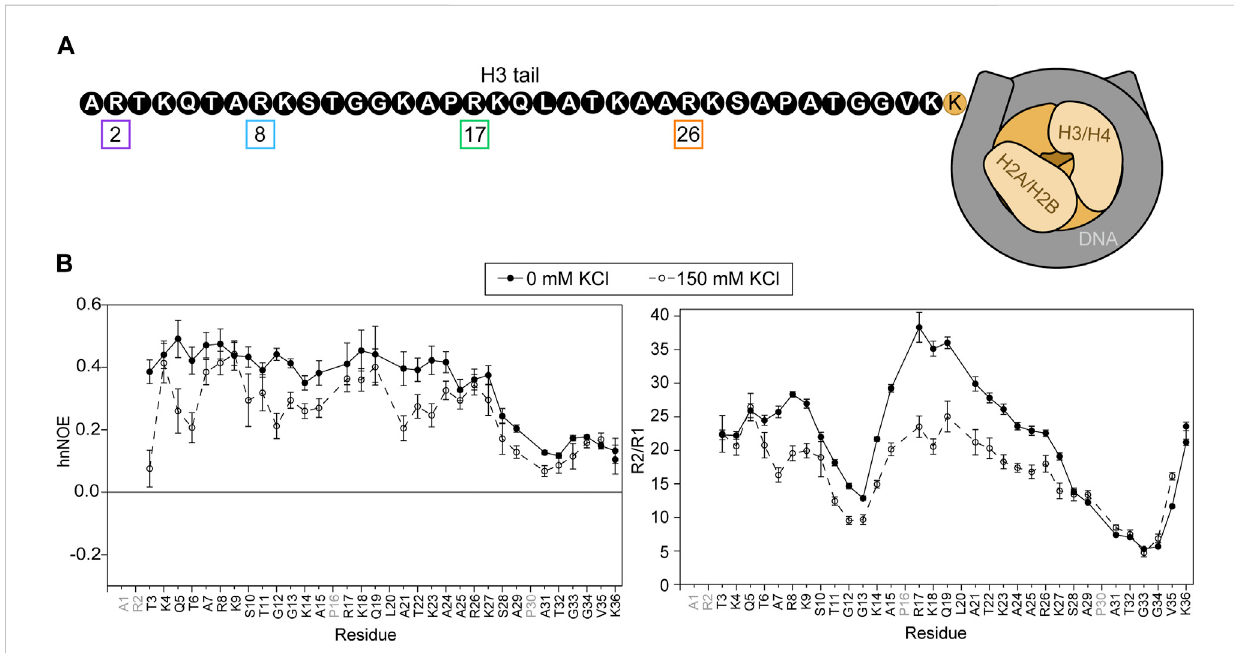
FIGURE 1 BasalstateoftheH3tailwithintheNCP. (A) AcartoondepictionoftheNCPshowsacomplexoftwoH3/H4dimersandtwoH2A/H2Bdimers(shades ofbeige)wrappedbyDNA(grey).TheH3tailsequenceisexplicitlydepicted(nottoscale)inblackandwhite.Arginineresiduesarenumberedandboxedin colors corresponding to plots in subsequent fi gures. (B) Amide nuclear spin relaxation data is shown for 15 N-WT-H3-NCP in the absence (closed circles, solid line) and presence (open circles, dashed line) of 150 mM KCl. HnNOE (left) and R2/R1 (right) are plotted as a function of H3 tail residue. Two values are plotted for doublet peaks (see Section 2). Error bars represent standard error propagation of the spectral noise for hnNOE values and were determined via the covariance matrix in fi tting R1 and R2 decay curves, which was subsequently propagated for R2/R1. Data were collected at 800 MHz and 304